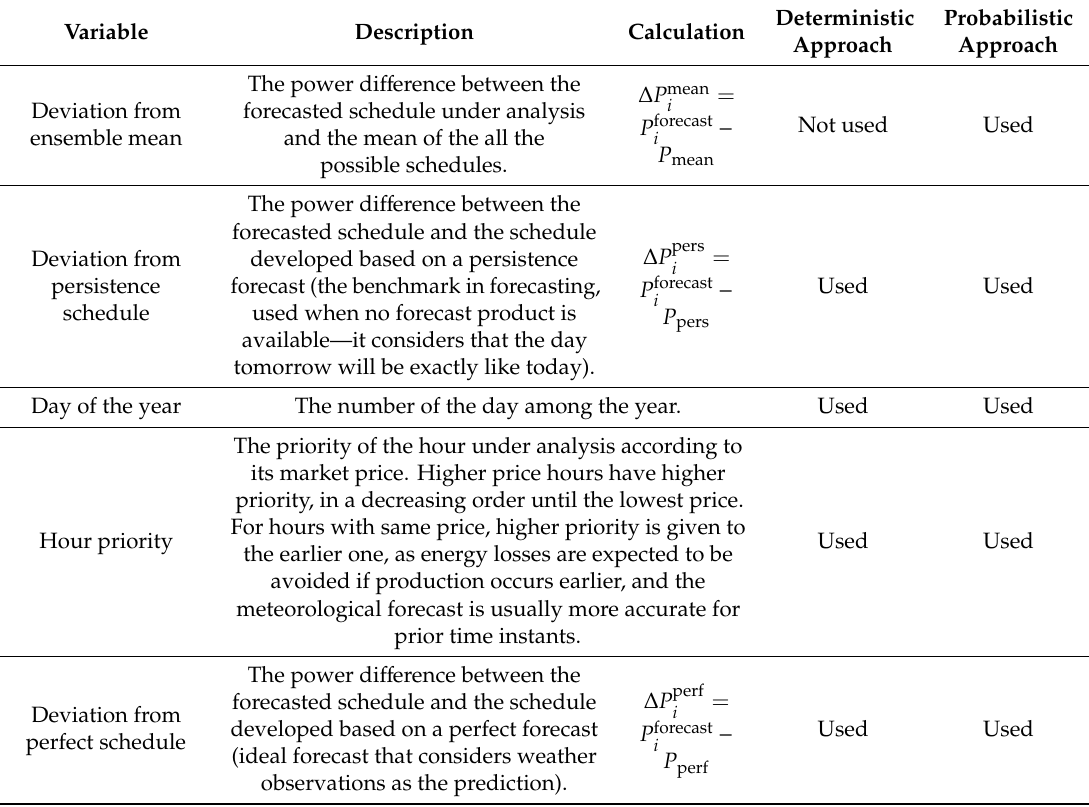
Table 1. Description of UPP learning variables for the deterministic and probabilistic approaches.